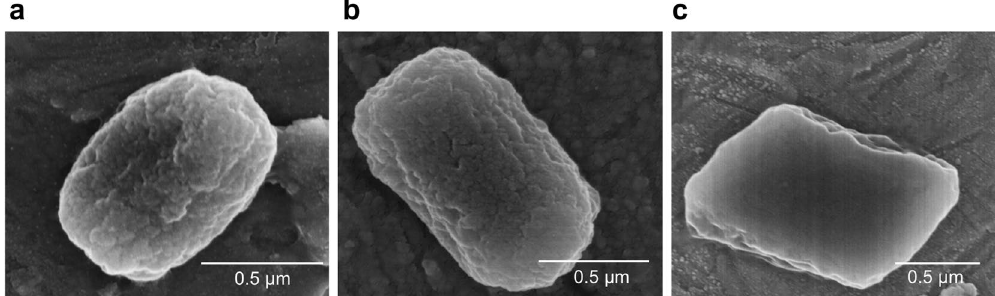
Figure 2. Single crystal comparison of Cry3Aa and Cry3Aa-lipA fusion crystals. ( a ) SEM of a purified Cry3Aa- lipA crystal, and ( b ) purified Cry3Aa * -lipA crystal at 60,000 × magnification. ( c ) SEM of a purified Cry3Aa crystal at 45,000 × magnification.